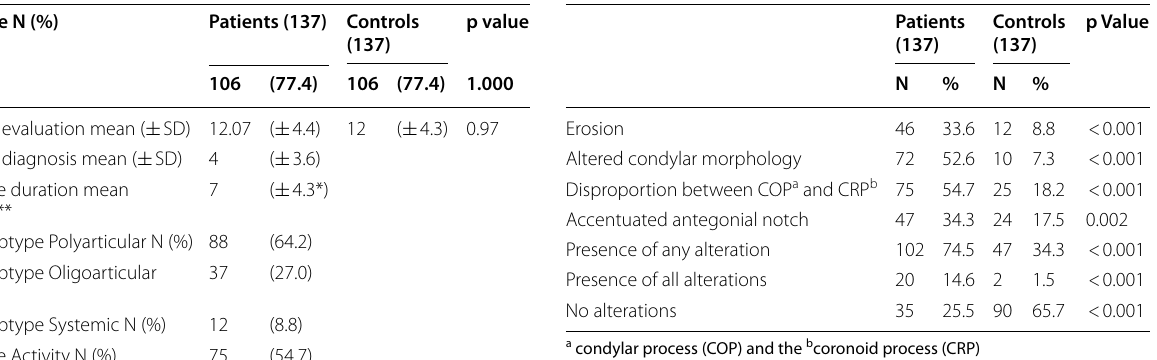
Table 2 Radiographic changes in panoramic radiographs of patients with juvenile idiopathic arthritis and control